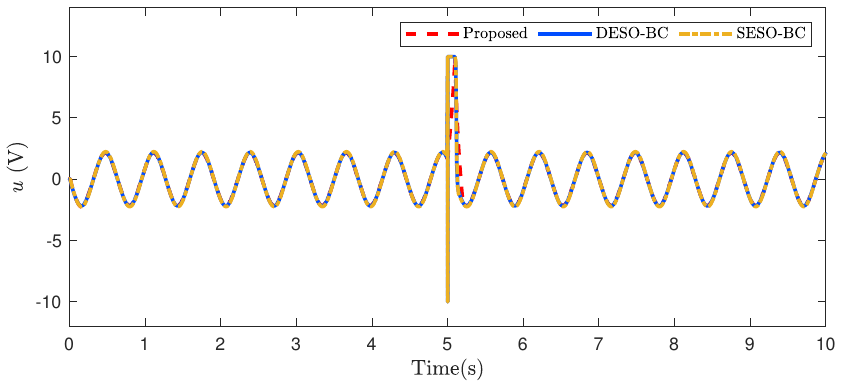
Figure 7. Control actions of all control approaches in case of step reference trajectory.